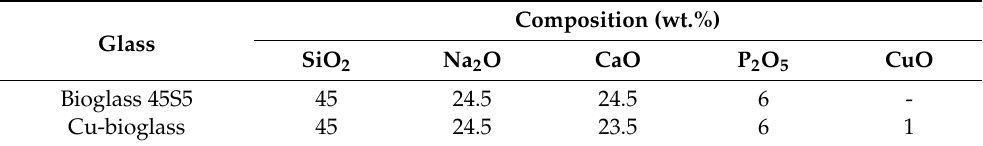
Table 1. Bioglass and Cu-bioglass